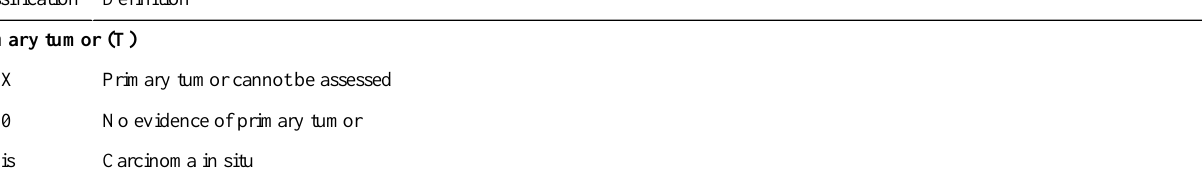
Table 1. T, N, and M classifications for cancer of the lung.